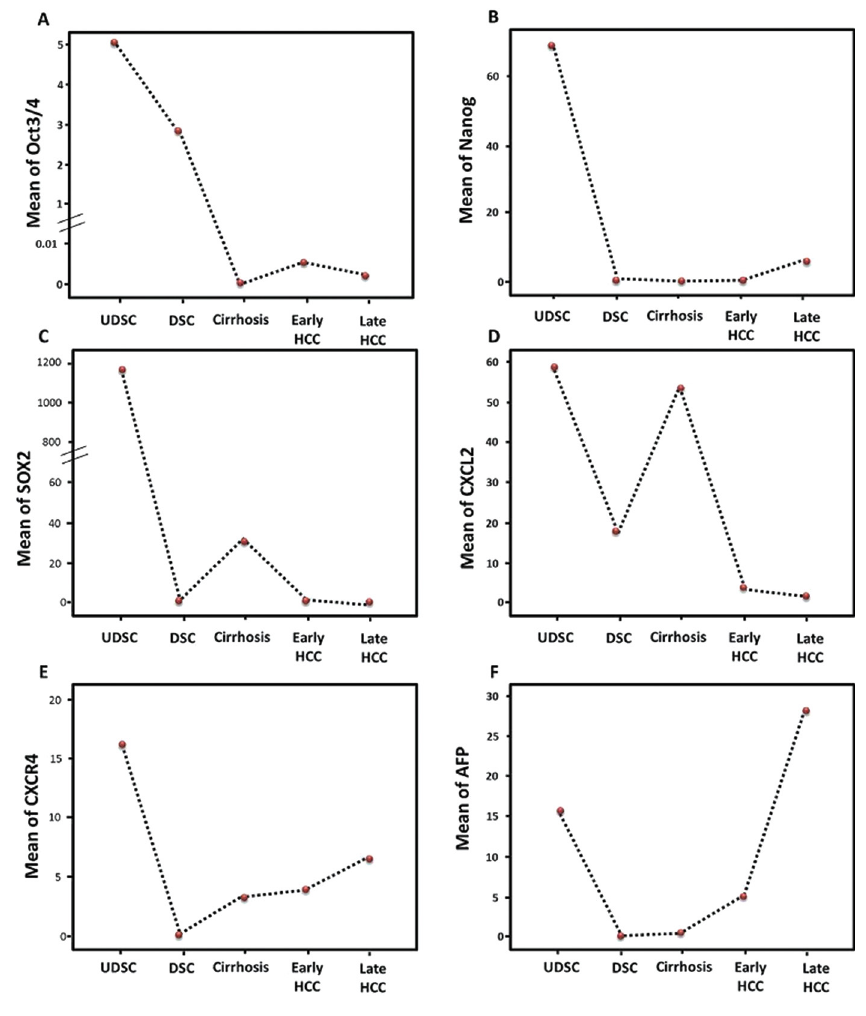
Figure 1. Gene expression levels in cultured stem cells and hepatic patients. Data are presented as means. ANOVA test was used, followed by Newman-Keuls multiple compar- ison test at 0.05 significance levels. UDSC, undifferentiated stem cells; DSC, differentiated stem cells; HCC, hepatocellular